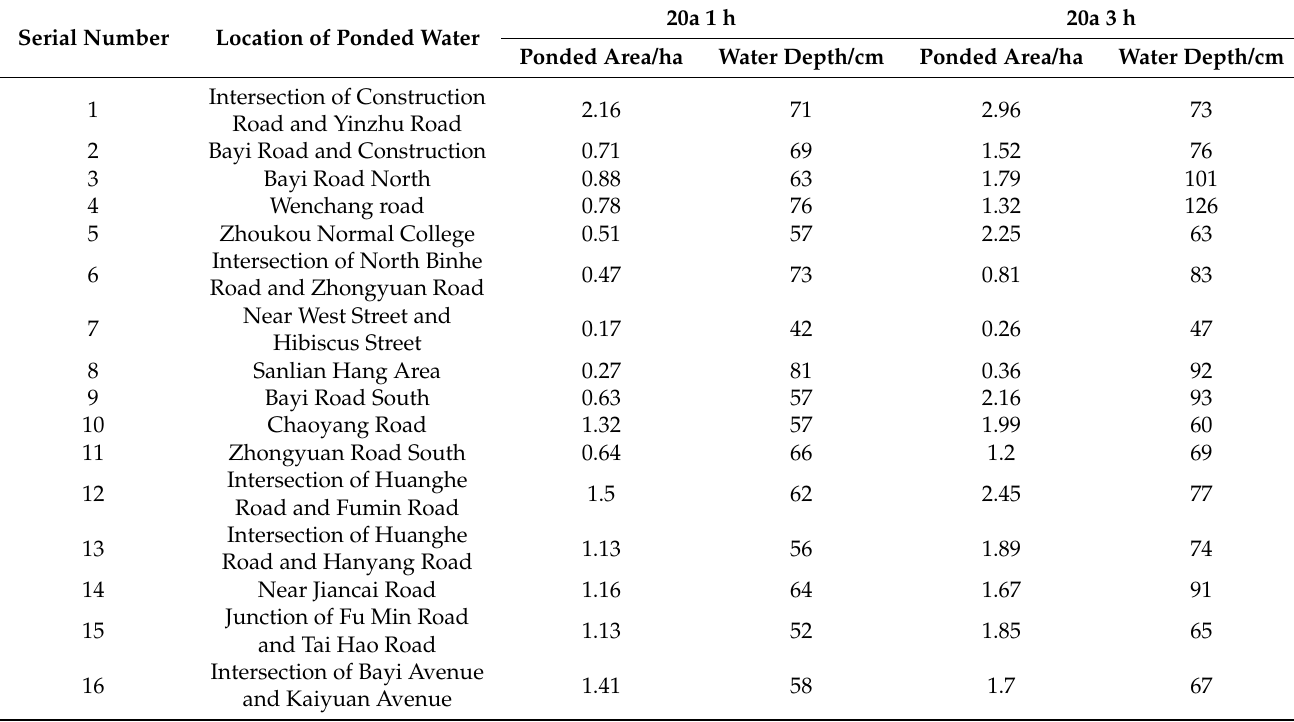
Table 3. Depth and area of water at major flood prone points during a 20-year rainfall event.